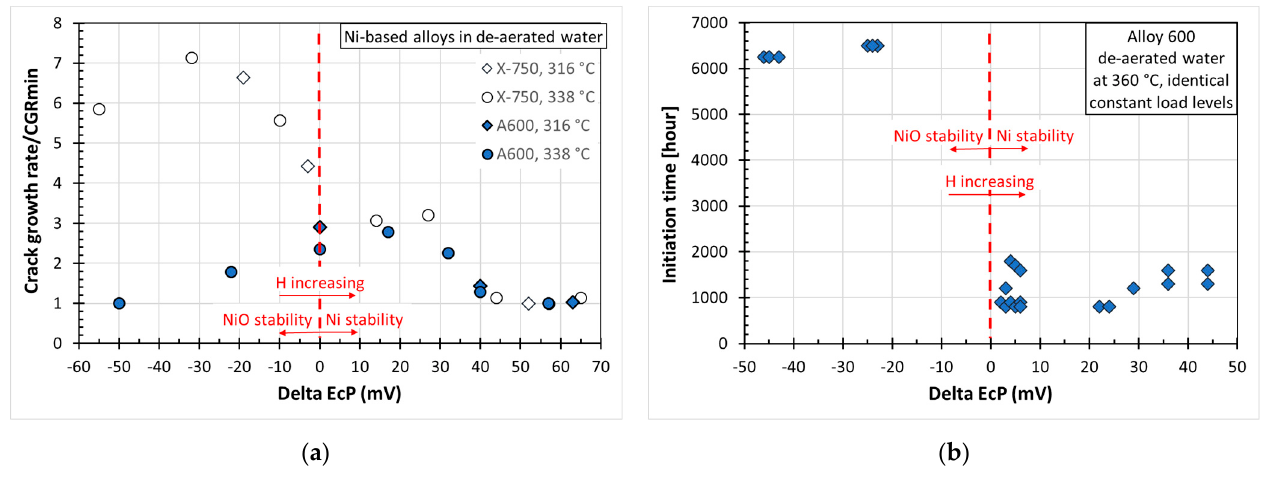
Figure 7. EAC susceptibility of Ni-based alloys as a function of the content of dissolved H 2 in water. ( a ) Chart of the EAC crack growth rate normalized to a minimum value (CGRmin) of X-750 and A600 alloys, exposed to de-aerated water at 316 °C and 338 °C, versus the difference of electrochemical potentials from the NiO/Ni transition (Delta EcP). The results show that maximum values are found in a distance close to the Ni/NiO transition. The chart is based on the published data [57]. ( b ) Chart of the EAC initiation time of high-temperature-annealed Alloy 600, exposed to de-aerated water at 360 °C with identical stress applied, versus Delta EcP. The results show that the EAC initiation times are much longer under conditions with stability of the nickel oxide than they are with stability of the nickel metal. The chart is based on published data [56].